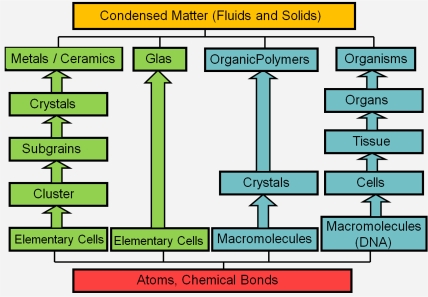
Schematic hierarchical view of structural properties of important classes of materials contrasting typical structural features of inorganic crystalline materials (engineering materials, green) and the structural features of self-organizing organic biological materials (blue). At the nanoscale, the basic constituents of all condensed matter are the atoms bound together in chemical bonds.